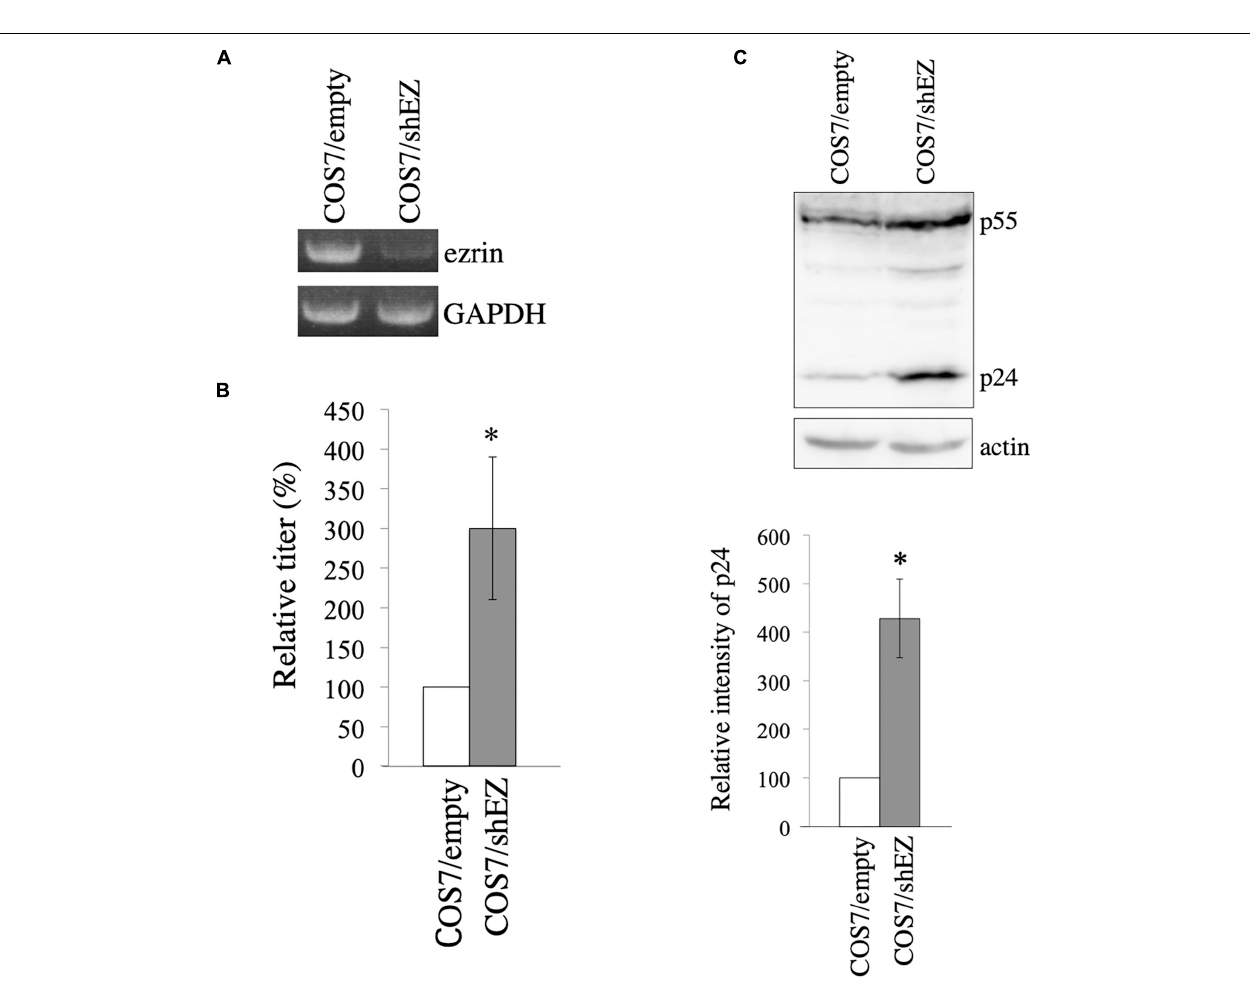
FIGURE 6 | Construction of COS7 cells stably silenced ezrin. (A) Levels of ezrin and GAPDH mRNAs in COS7/empty and COS7/shEZ cells were analyzed by RT-PCR. (B) COS7/empty and COS7/shEZ cells were transfected with VSV-G-pseudotyped HIV-1 vector construction plasmids. Culture supernatants from the transfected cells were inoculated to TE671 cells, and transduction titers were measured. Relative values to the transduction titers in the COS7/empty cells are indicated ( n = 3). Asterisks show significant differences compared to COS7/empty cells. (C) Cell lysates prepared from the transfected cells were analyzed by western blotting using p24 and actin antibodies. HIV-1 Gag precursor (p55) and mature capsid (p24) were indicated (upper panel). Intensities of p24 protein were measured by a densitometer. Relative values to the intensities in the COS7/empty cells are shown (lower panel, n = 3). Asterisks show significant differences compared to COS7/empty